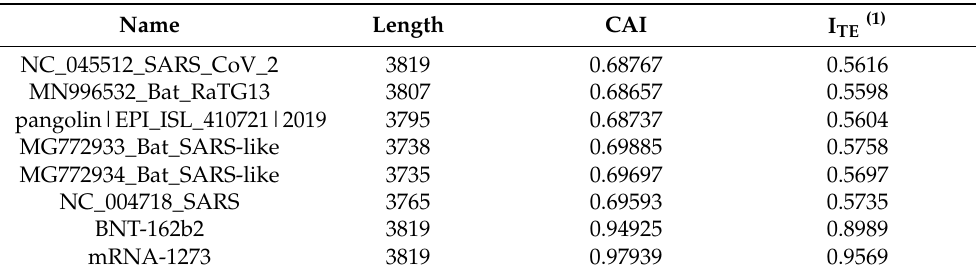
Table 4. Codon adaptation index (CAI) and index of translation efficiency (I TE ) for the coding sequences of the S gene from SARS-CoV-2 reference genome (NC_045512), SARS-CoV reference genome (NC_004718), their close relatives isolated from bats and pangolin, and the two mRNA vaccines (BNT-162b2 and mRNA-1273). Name Length CAI I TE